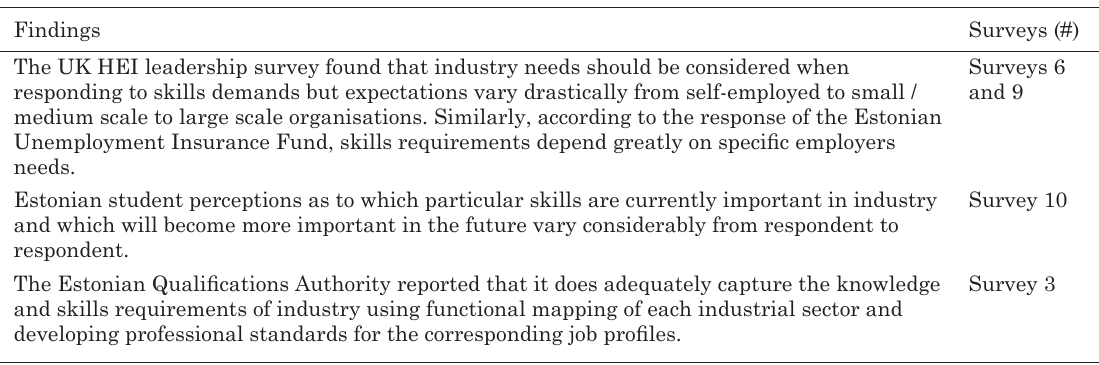
Table 4. Summarized findings relating to the conception of capture – response in the context of skills